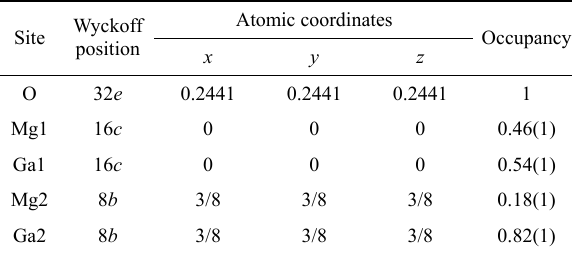
Atomic coordinates of spinel phase